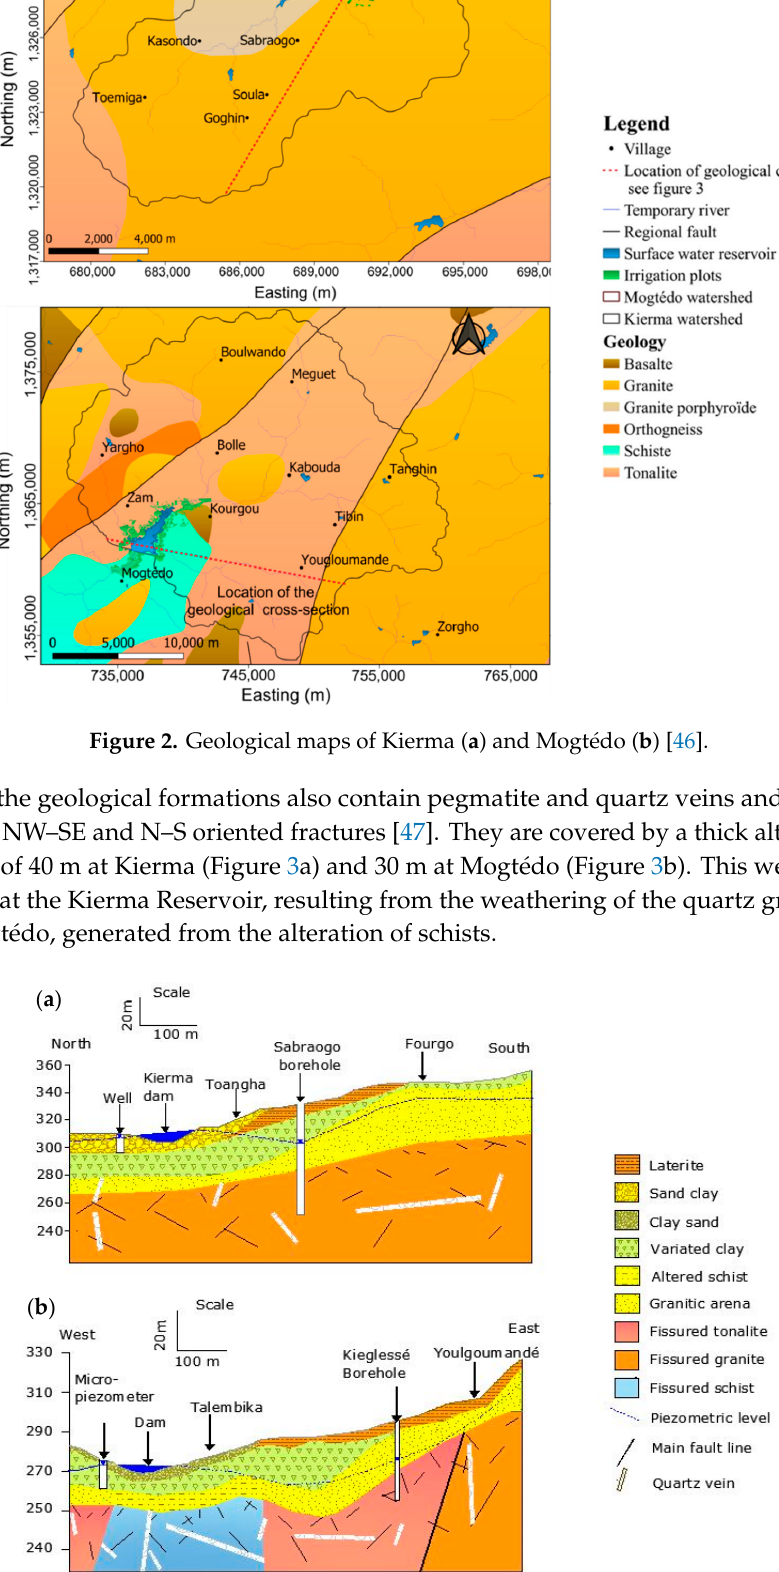
Figure 3. Geological cross-sections of Kierma ( a ) and Mogt é do ( b